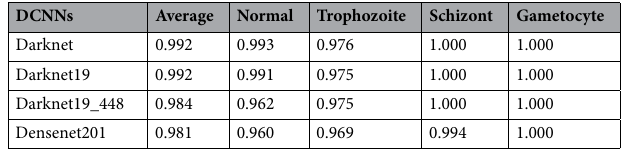
Table 3. Model-wise comparison and multiclass-wise comparison based on specificity from one-class versus total.